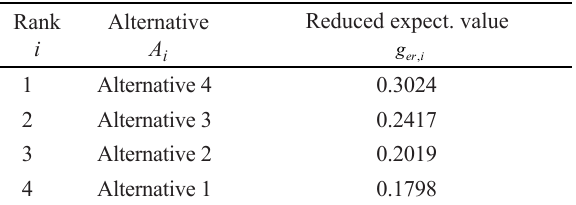
Table 6. Ranking of alternatives according to reduced g for uniform distribution, 1 β= expected values er